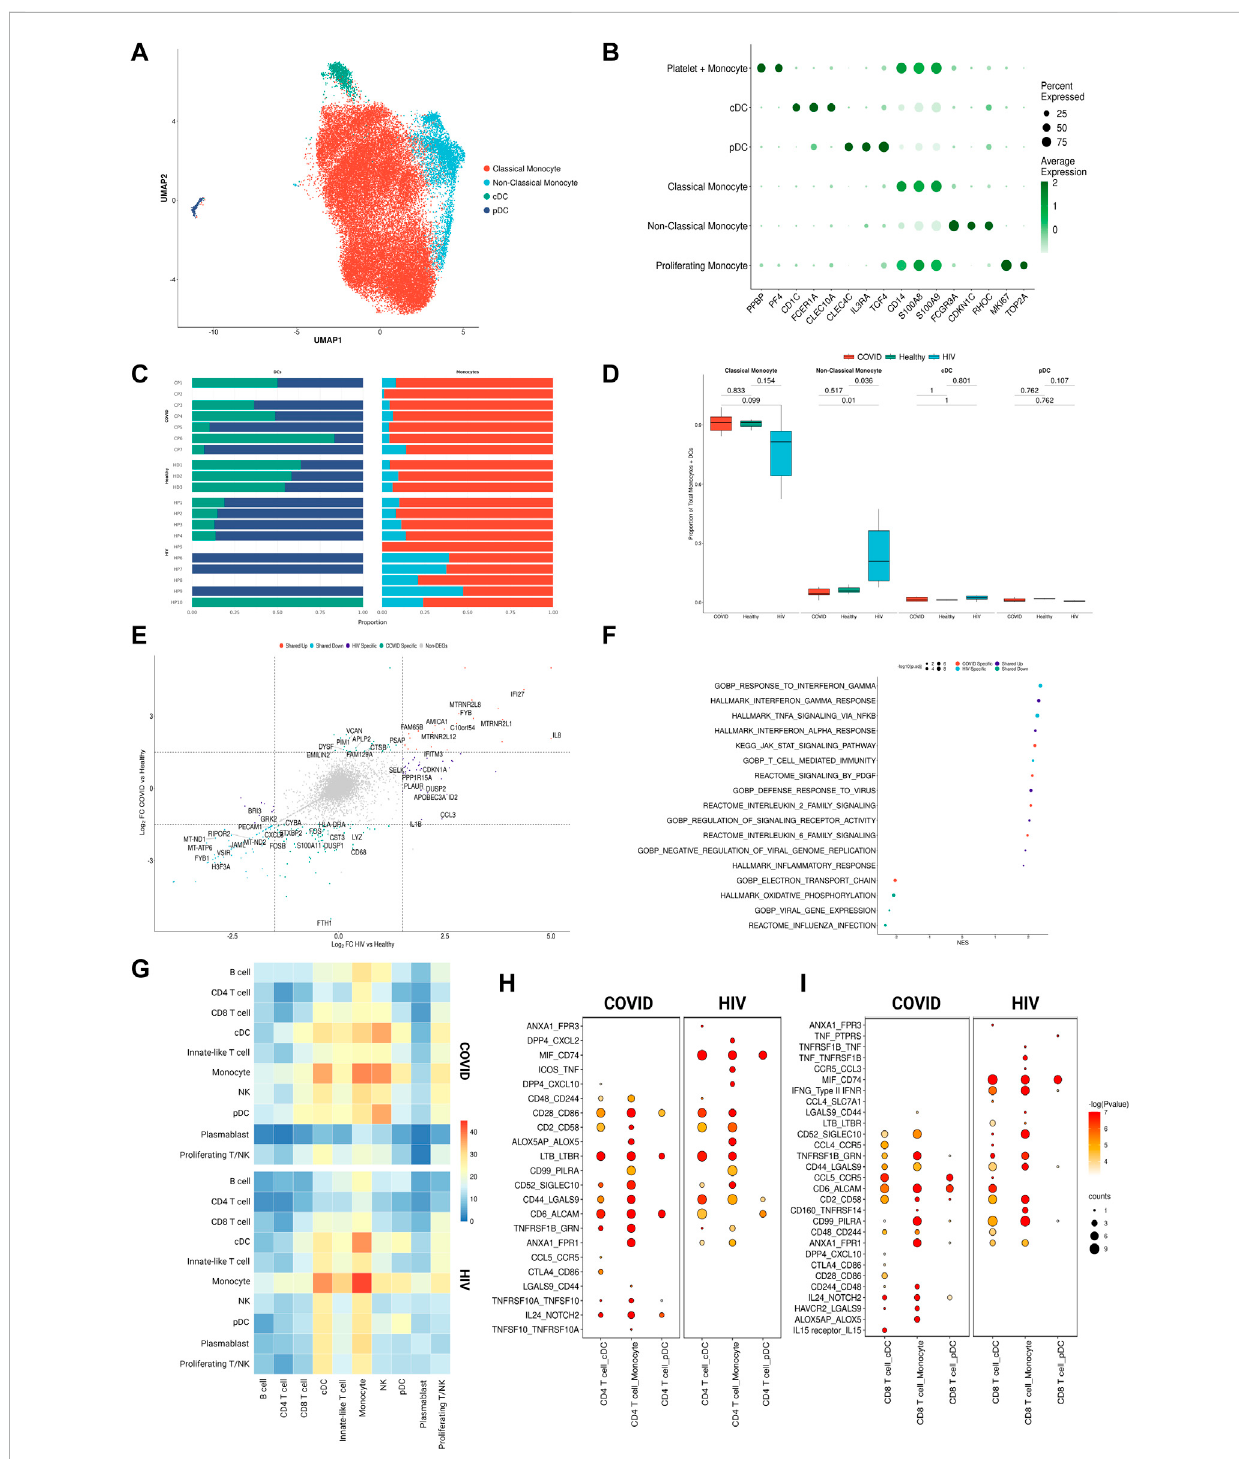
FIGURE 3 MonocytesinCOVID-19andHIV-1sharein fl ammatorysignatures. (A) UMAPembeddingsofmonocytesandDCscoloredbysubtype. (B) Dotplotofcanonical monocyte and DC marker expression across subtypes. (C) Stacked bar plots of the relative frequency of subtypes present in each patient. (D) Box plots of the proportionsofeachmyeloidsubsetacrosseachdiseasecondition.ProportionsarecomputedforeachpatientbydividingtheirnumberofcellsineachDC/monocyte subset by their total number of DCs + monocytes. p -values are computed with Wilcoxon signed-rank test with Holm-Bonferroni adjustment. (E) Double differential gene expression plot of genes that are differentially expressed between COVID-19 patients compared to healthy controls or differentially expressed between HIV-1 + patients compared to healthy controls. (F) Dot plot of enriched biological pathways from differentially expressed genes that were found to be upregulated(right,positive)ordownregulated(left,negative)comparedtohealthycontrols. (G) Heatmapofthenumberofreceptor-ligandinteractionsbetweeneach celltypeinCOVID-19patients(top)andHIV-1 + patients(bottom). (H) Dotplotofselectedreceptor-ligandinteractionsbetweenCD4 + Tcellsandmonocytes/DCsin